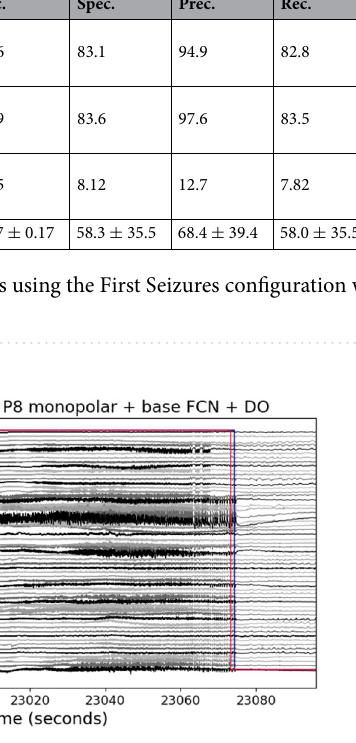
First seizures with intracranial electrodes